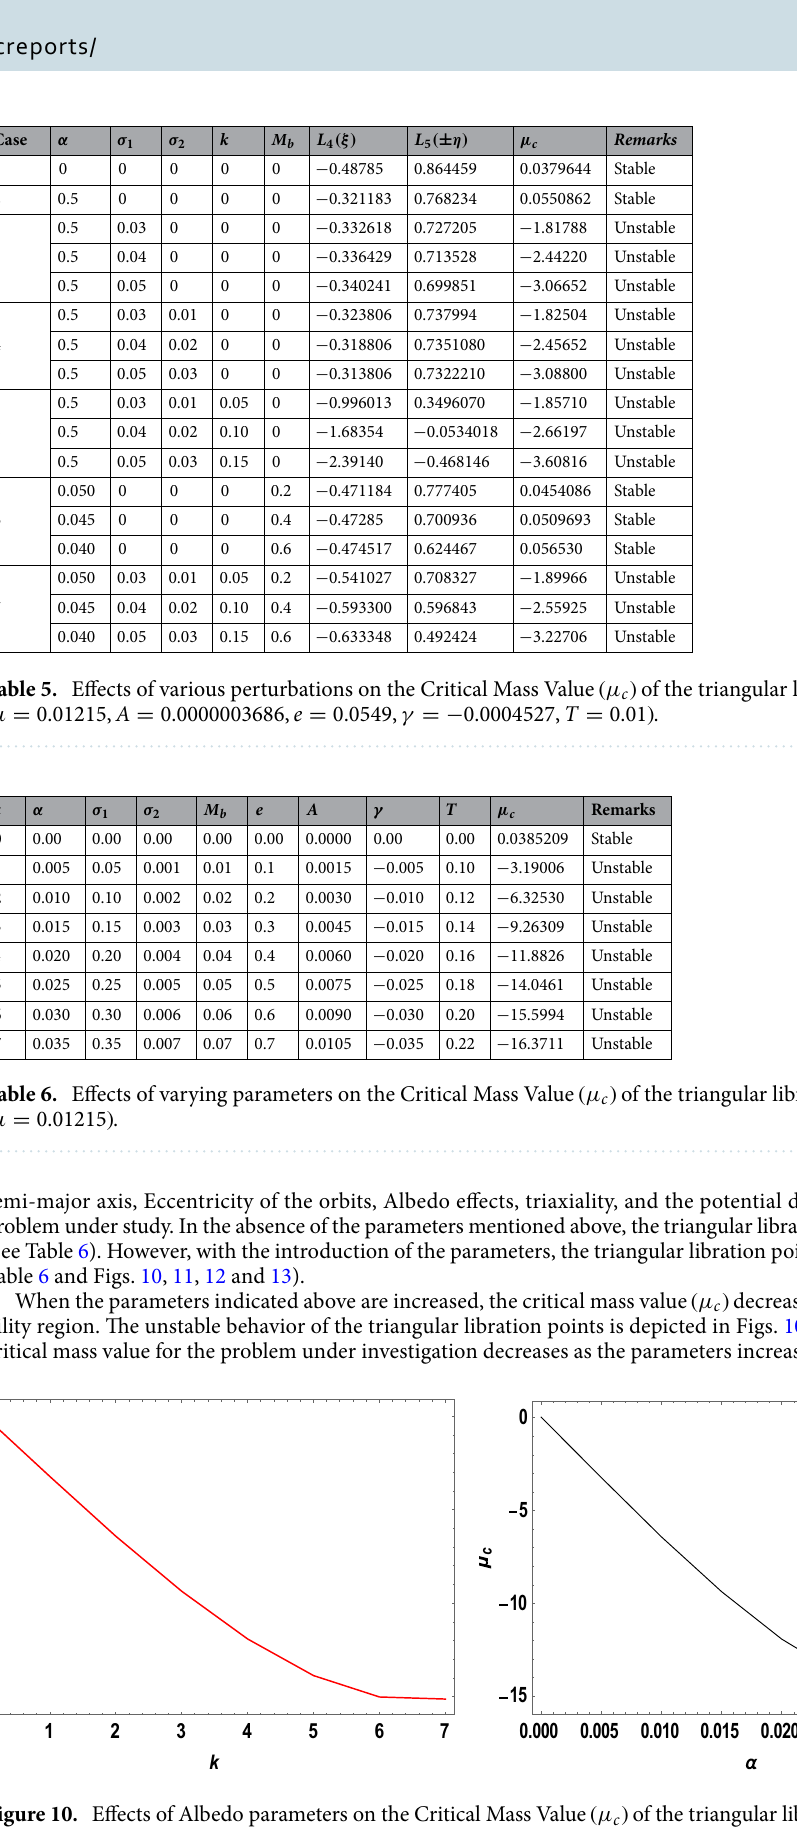
Figure 10. Effects of Albedo parameters on the Critical Mass Value (µ c ) of the triangular libration